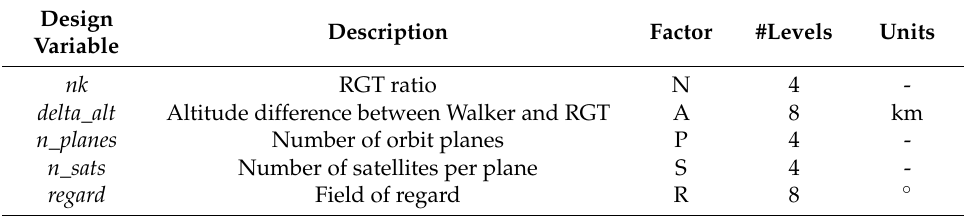
Table 8. Factors and Levels used in Latin Hypercube Sampling.